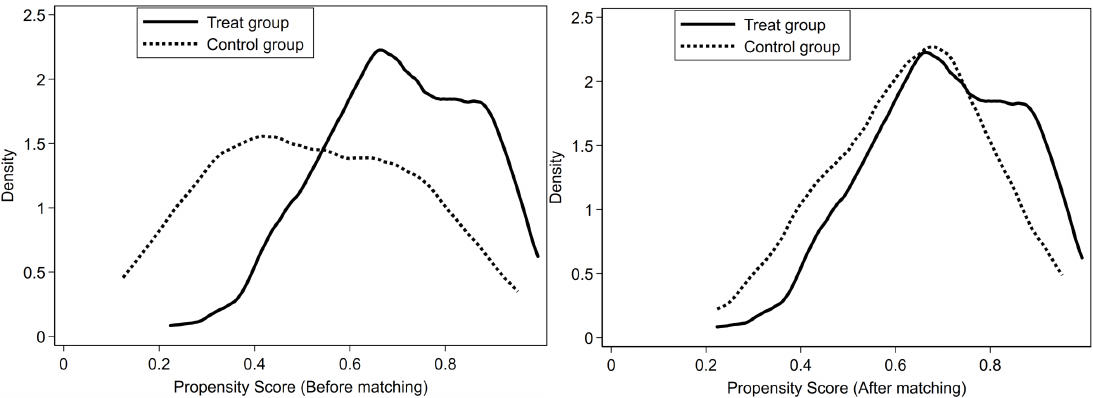
Figure 5. Kernel density function plot before and after propensity score matching.